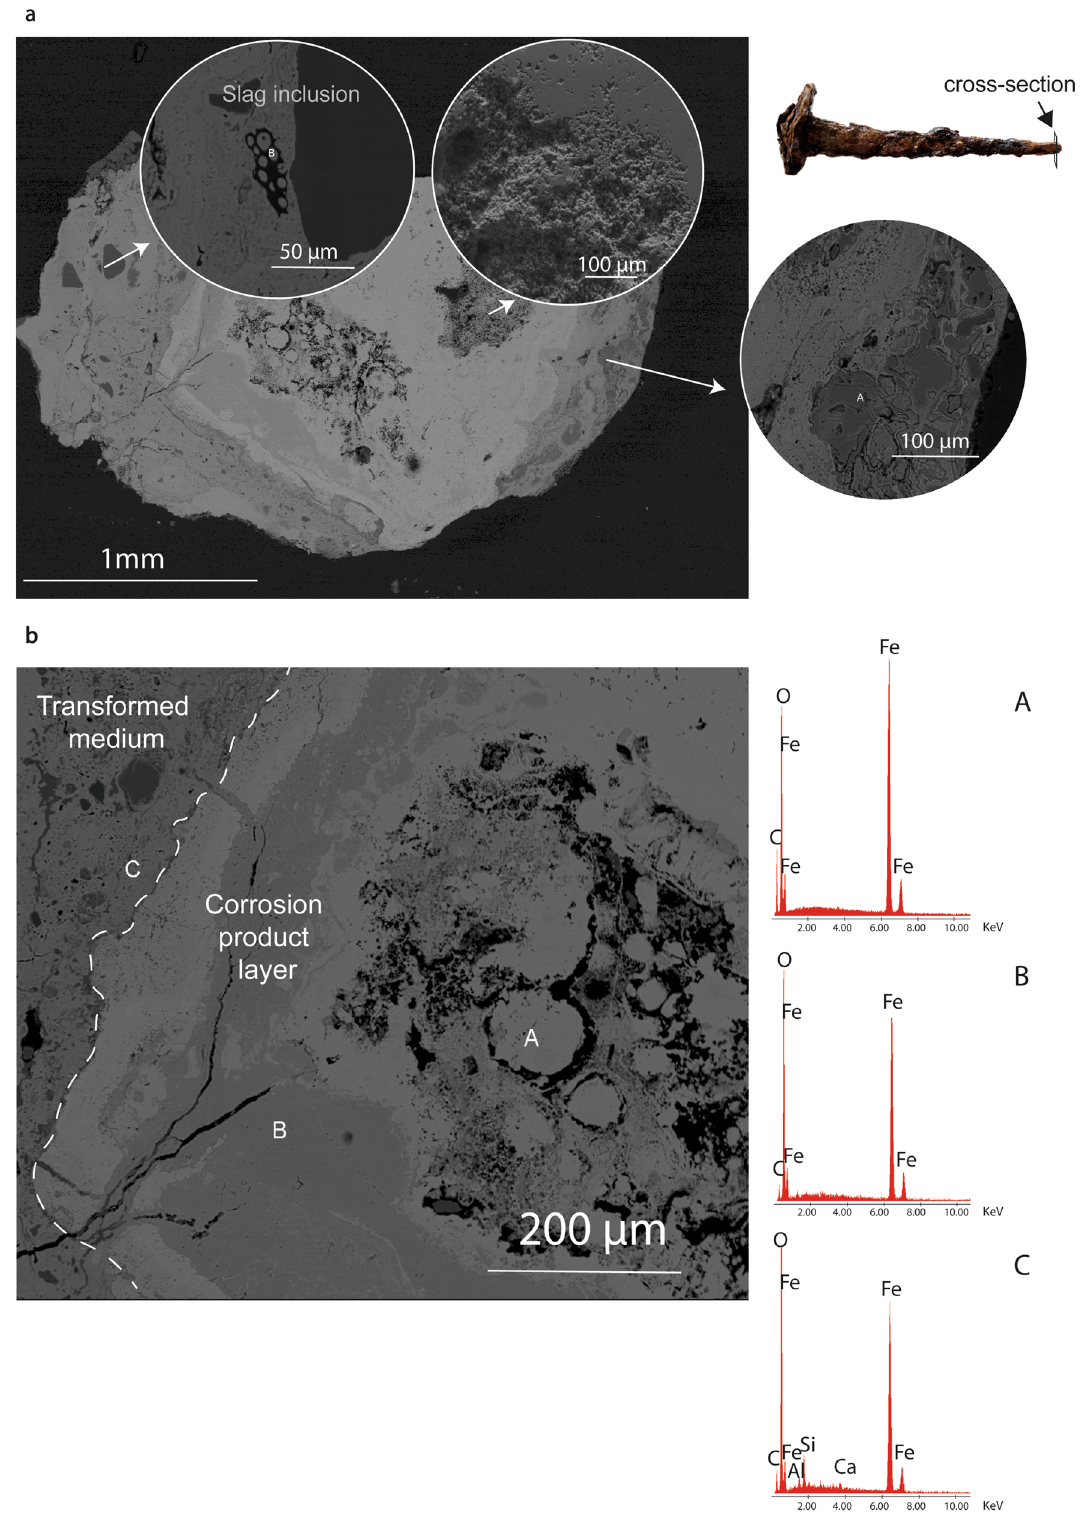
Figure 2. SEM–EDS images and spectra of the tip of the nail. ( a ) BSE image of the cross-section with the higher magnification images and spectra of slag inclusion, soil minerals and SE image of the crack. ( b ) Magnified view of the dense product layer